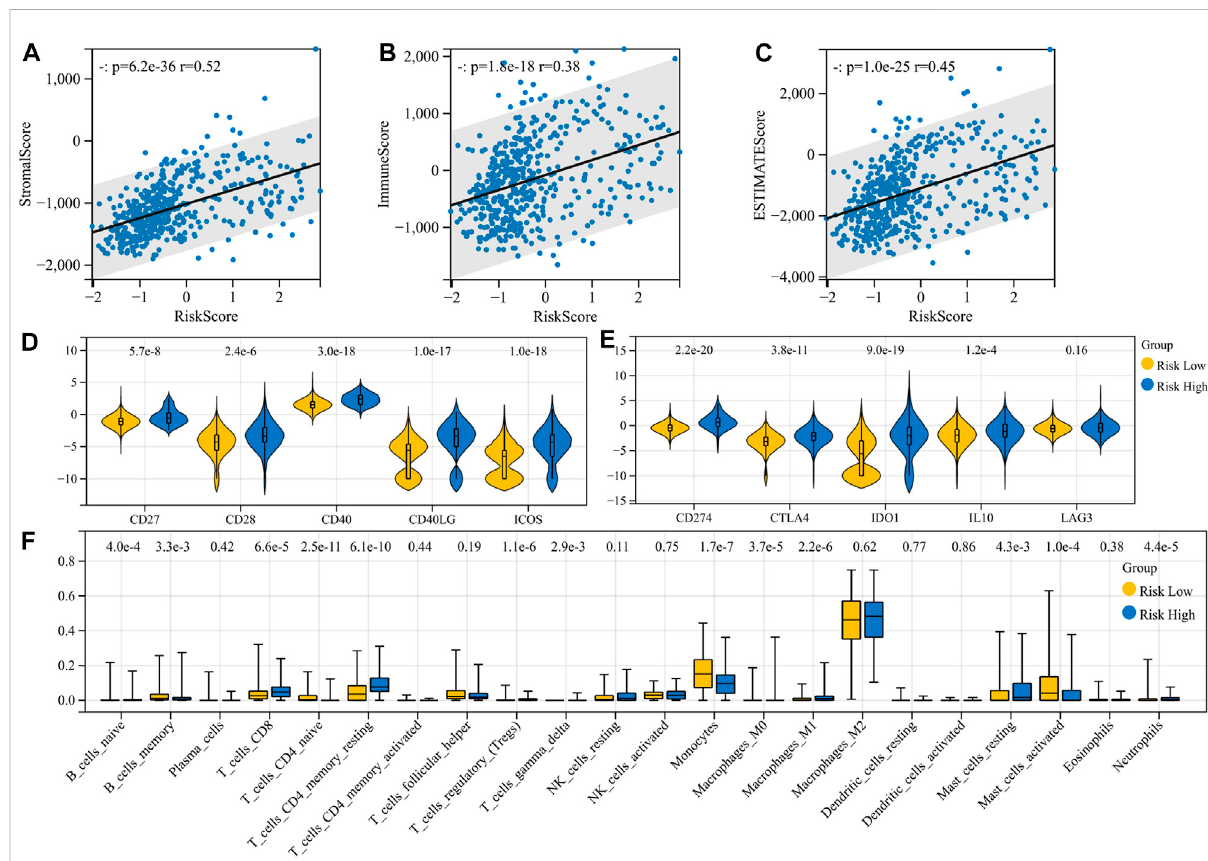
FIGURE 3 Immunocorrelation analysis of the risk model. (A – C) Correlation of the risk model with immune in fi ltration scores; (D – E) correlation of the risk model with the expression of immune molecules; and (F) correlation of the risk model with immune cell in fi